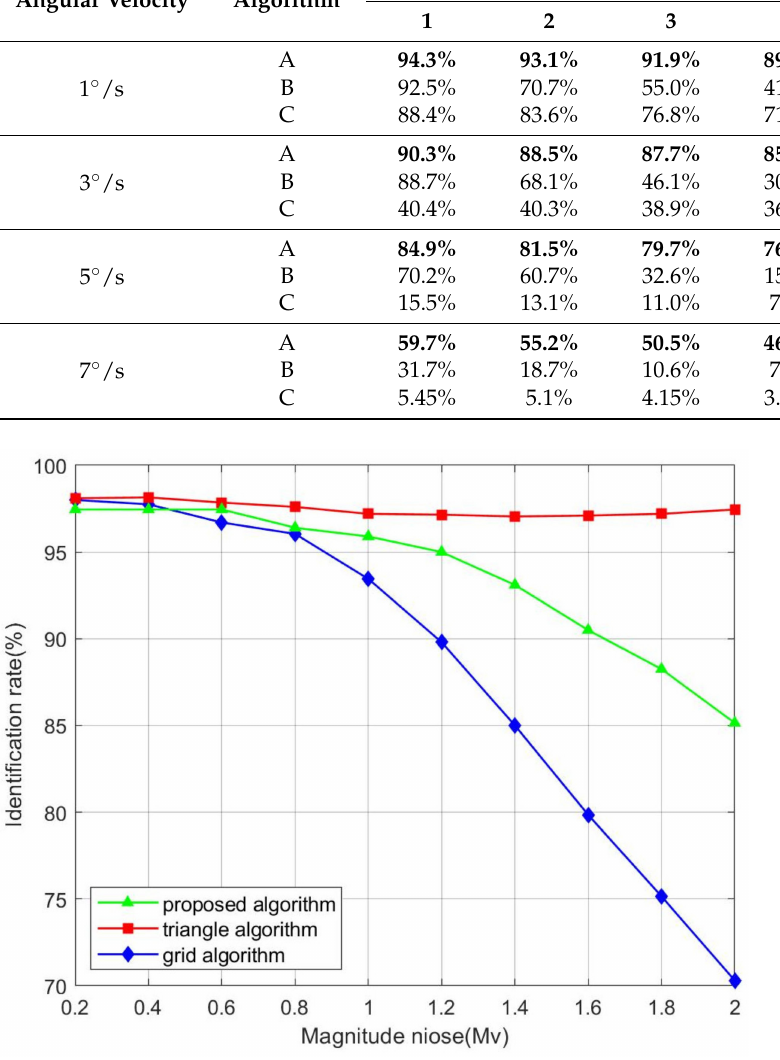
Figure 10. Effects of star magnitude noise on the identification rate at an angular velocity of 0 ◦ /s. Table 3. Identification rate of different magnitude